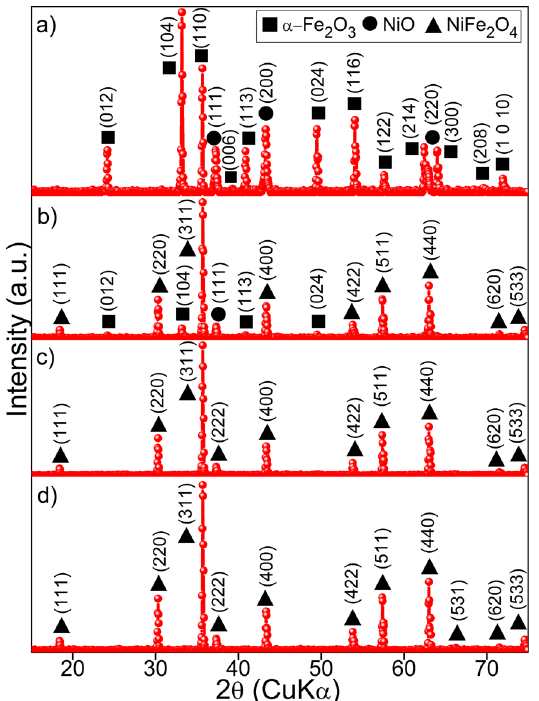
Figure 1. XRD patterns of (a) the initial mixture of reactants and of the samples submitted to heat treatments at (b) 1000 ºC, (c) 1100 ºC and (d) 1200